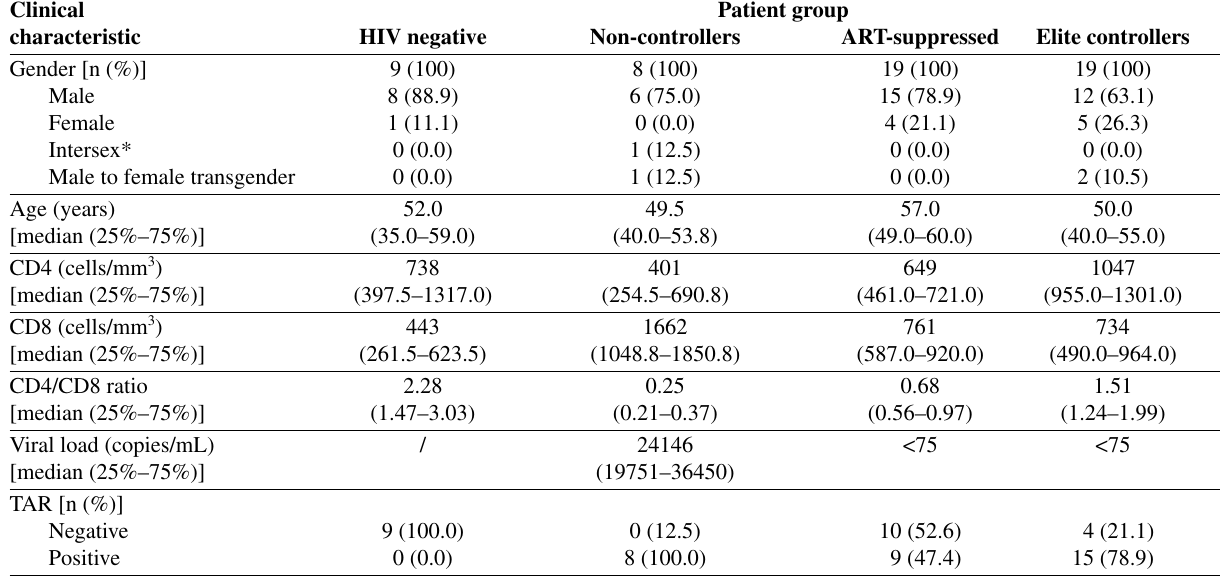
Table 1: Clinical characteristics of the study participants.